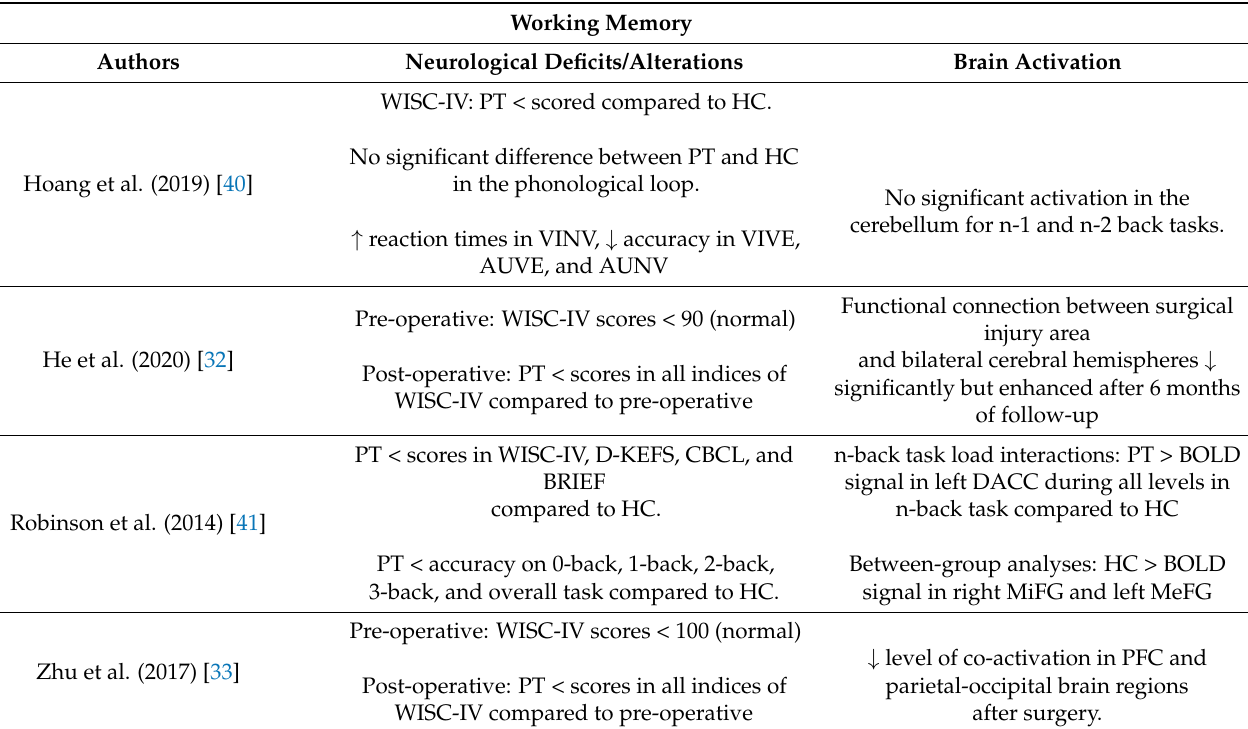
Table 5. Summary of neurological and psychological deficits and alteration in brain activity due to tumour